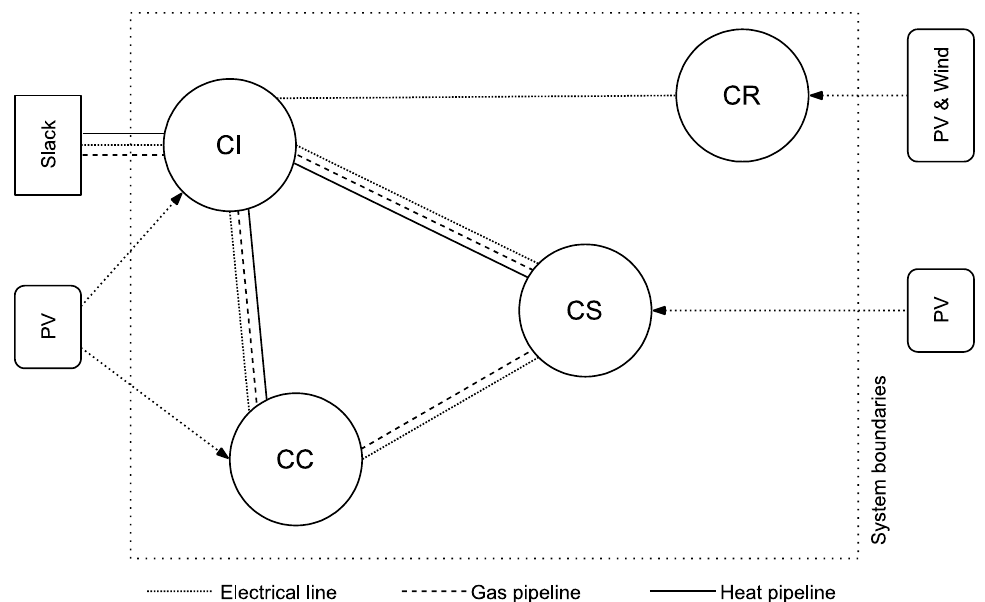
Figure 3. Network topology of the model city and available RES potentials. CC: city centre, CS: suburbs, CI: industrial areas and CR: rural areas.